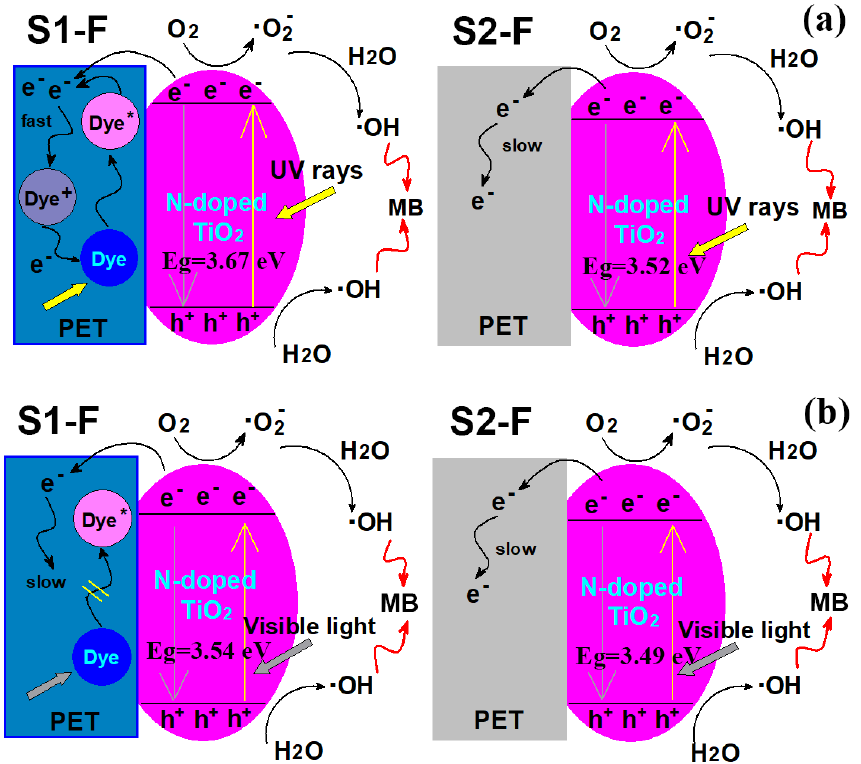
Figure 8. Schematic diagrams of the proposed photocatalytic mechanism of the PET filaments deposited with N-doped TiO 2 nanoparticles sensitized with water insoluble disperse blue SE–2R dye under ( a ) UV and ( b ) visible light irradiation.